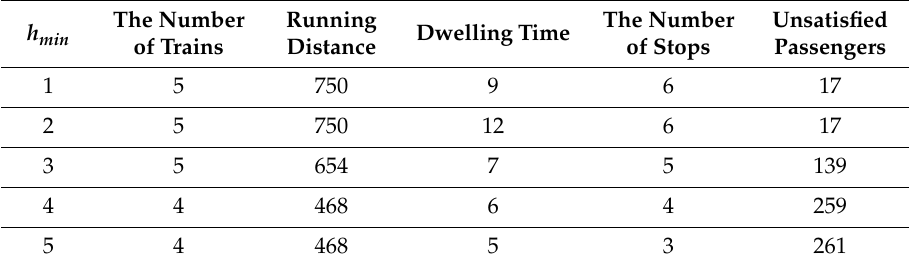
Table 9. Optimized solutions obtained under the minimum headway h min